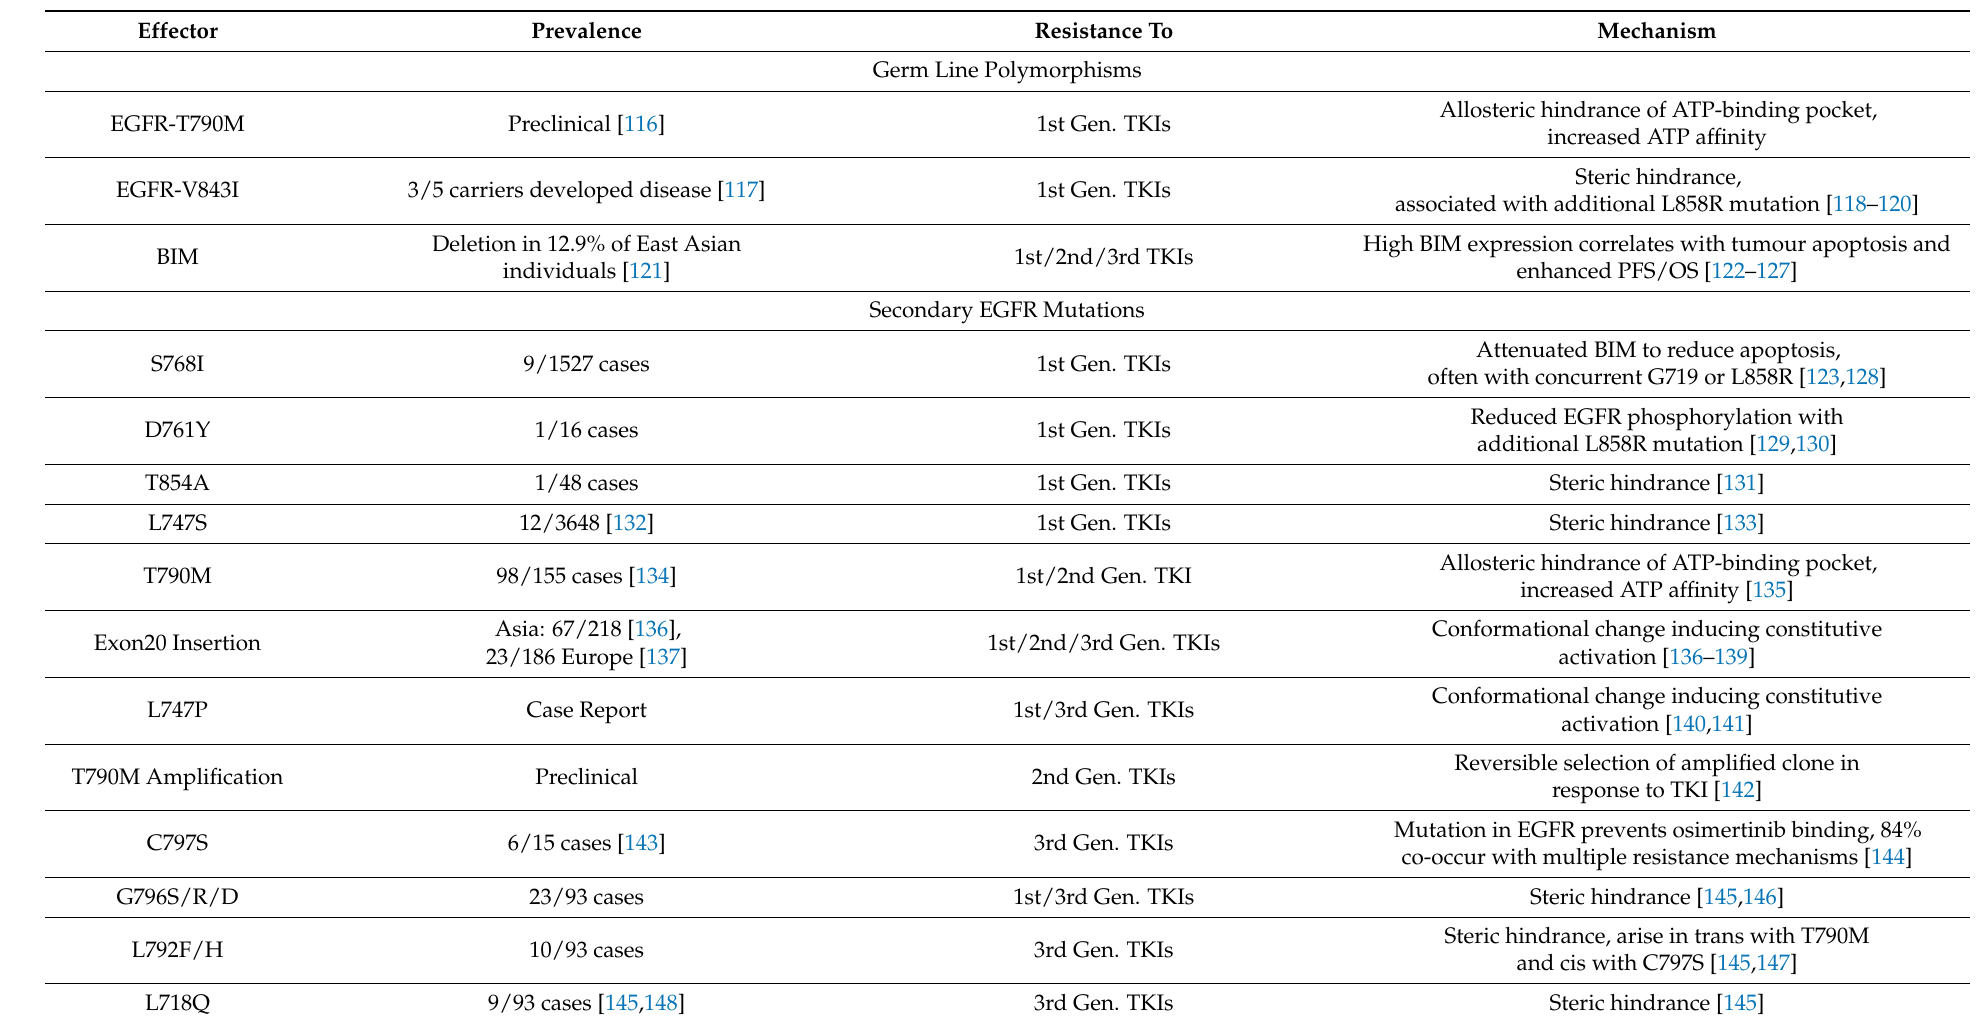
Table 3. Mechanisms of NSCLC resistance to TKI Therapy